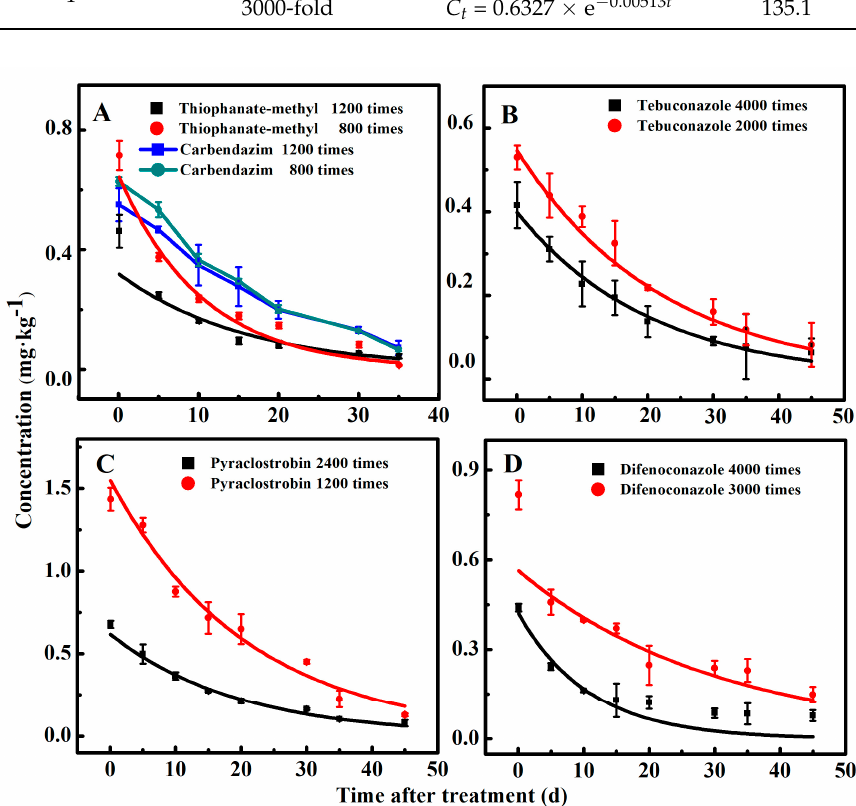
Figure 3. Dissipation dynamics of thiophanate-methyl and carbendazim ( A ), tebuconazole ( B ), pyraclostrobin ( C ), and difenoconazole ( D ) in pears at 25 °C.